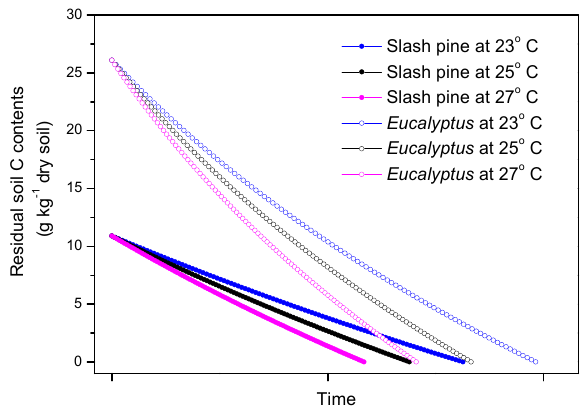
Figure 3. Residual soil C contents with β -glucosidase at 23, 25 and 27 ◦ C under slash pine and Eucalyptus over time. The total soil C decomposition over time was calculated via Eq. (5) and the resid- ual soil C contents over time was compared for different enzyme activities among the tree